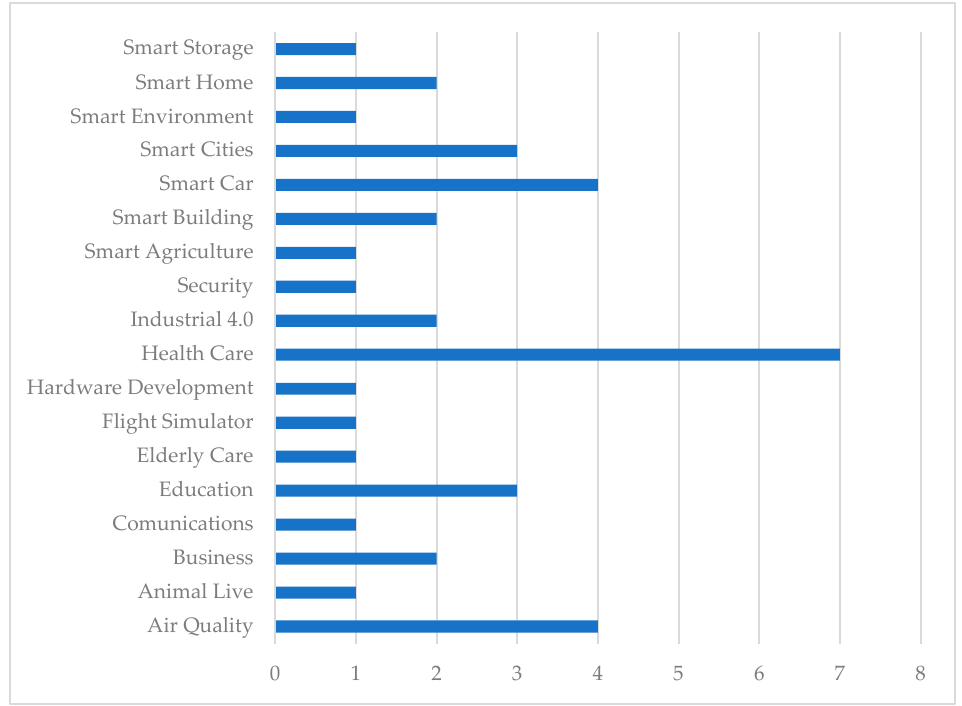
Table 3. Methodologies specifying the stages of the life Figure 5. IoTSs application areas are developed with methodologies designed for ISs.